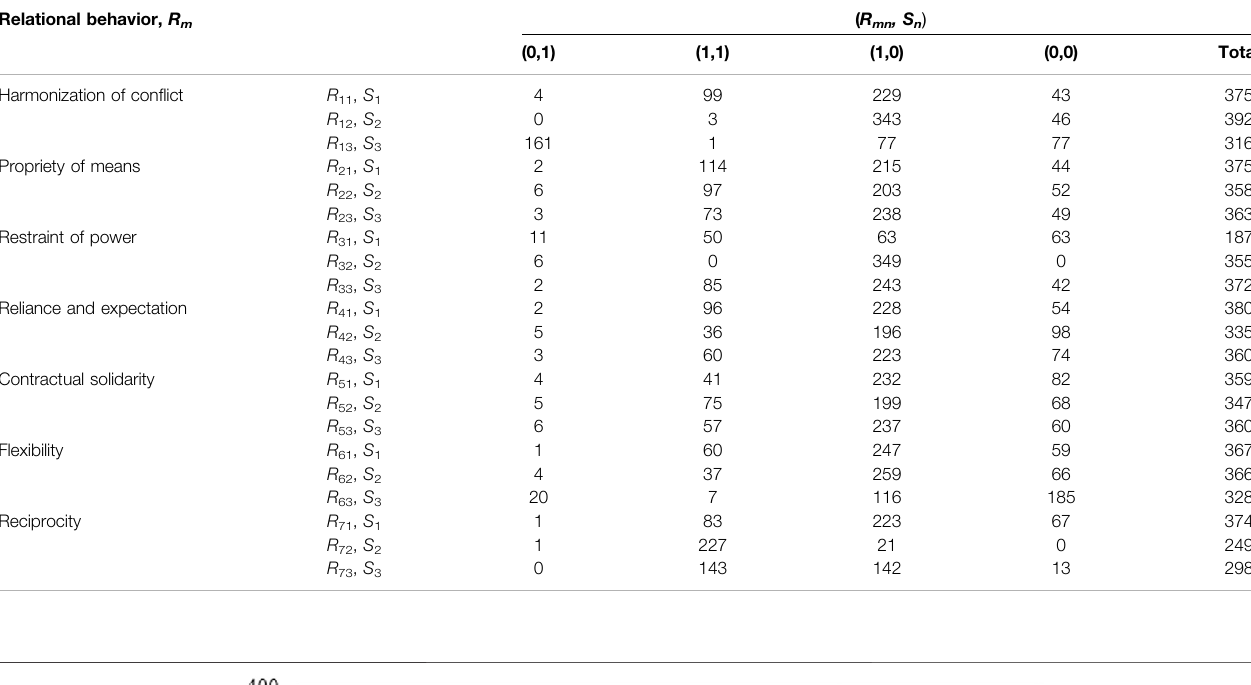
TABLE 1 | Absolute frequencies for relational and social behavior data. Relational behavior, R m